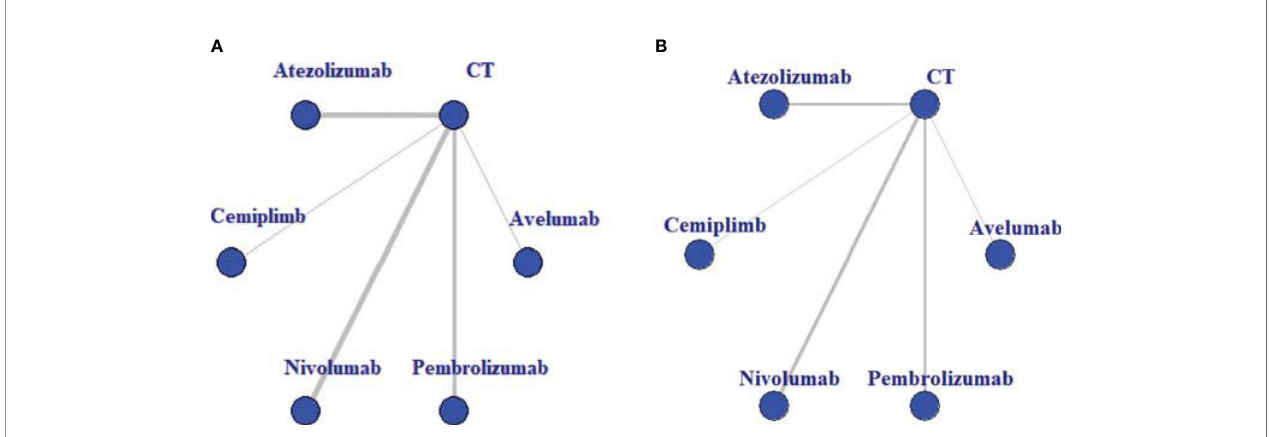
FIGURE 2 | Evidence structure of overall survival (A) and treatment-related adverse events (B) . All immune checkpoint inhibitors (ICIs) are represented as blue solid circles, and existing head-to-head (direct) comparisons are drawn as black solid lines. The size of every node is proportional to the number of randomly assigned participants (sample size), and the width of the lines is proportional to the number of randomized controlled trials (RCTs) for each pairwise comparison. CT,